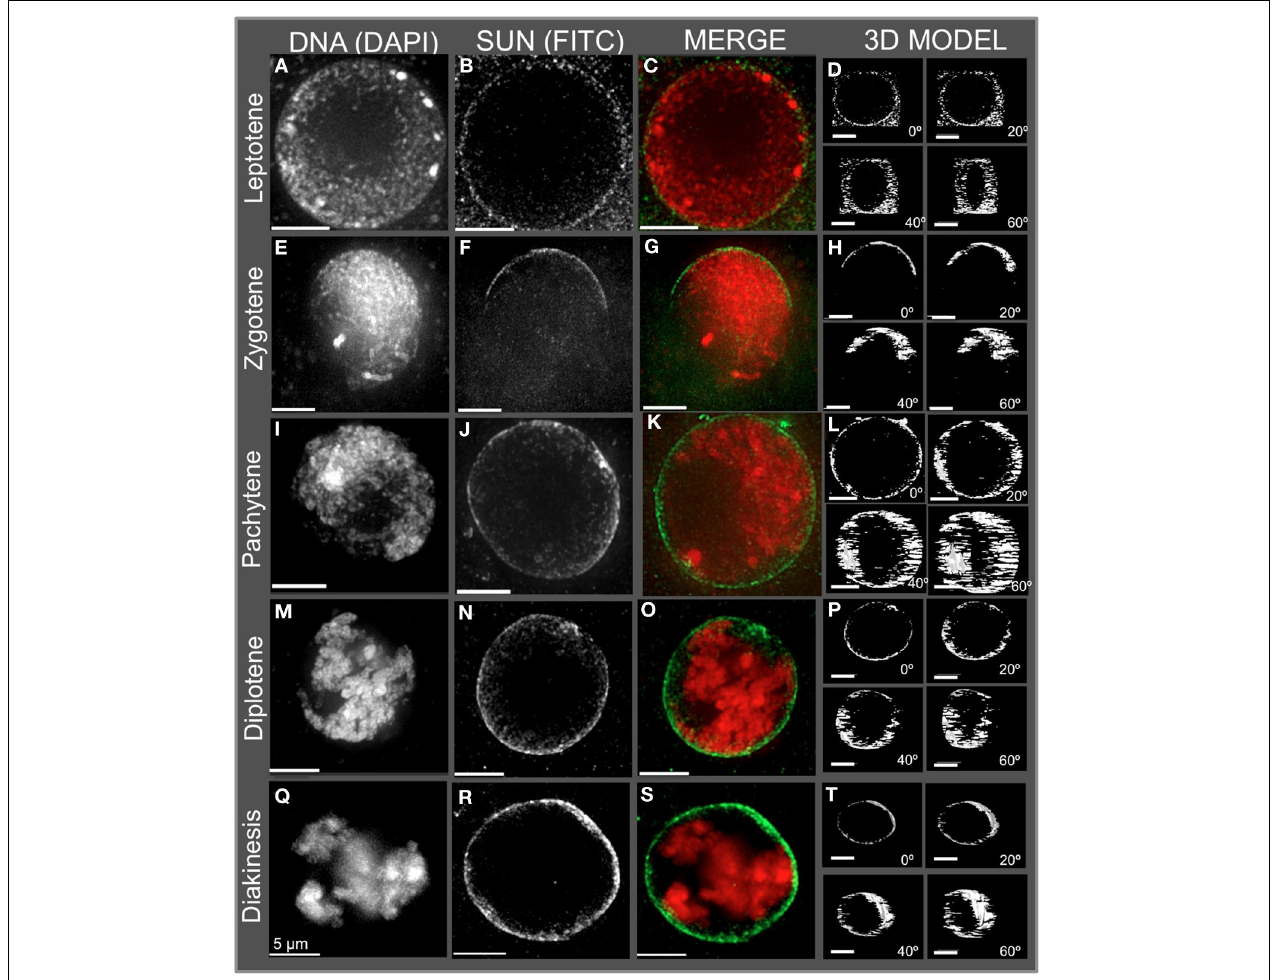
FIGURE 2 | Immunolocalization of the maize CCSD class of SUN proteins in meiotic cell nuclei. Protein immunolocalization using reagents that detect endogenous SUN2 (and likely SUN1) proteins were used to stain (A–C) leptotene, (E–G) zygotene, (I–K) pachytene, (M–O) diplotene, and (Q–S) diakinesis stage meiotic nuclei from maize. DAPI (total DNA, red) and